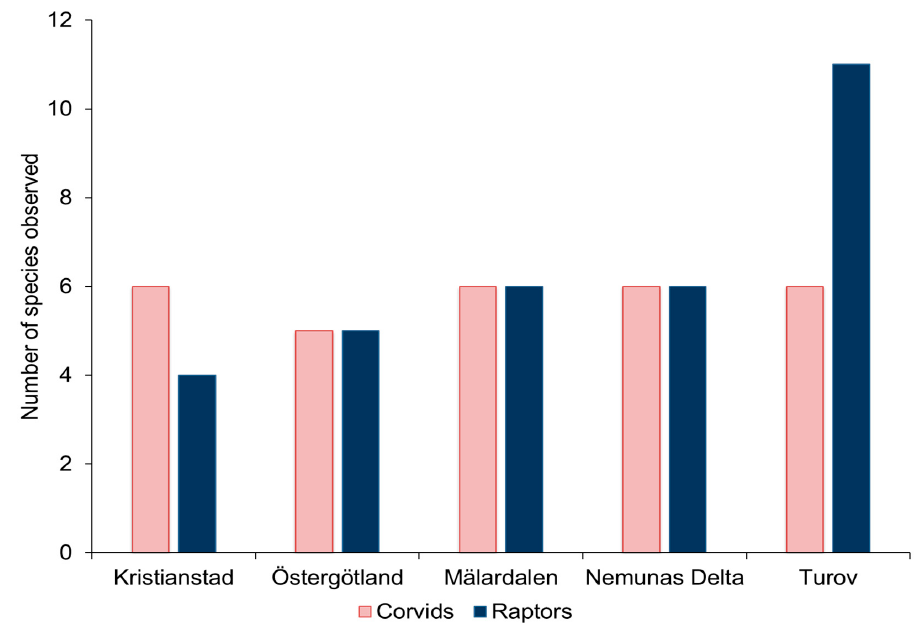
Figure 2. The number of corvid and raptor species observed in the five case study landscapes in the Baltic Sea Region.